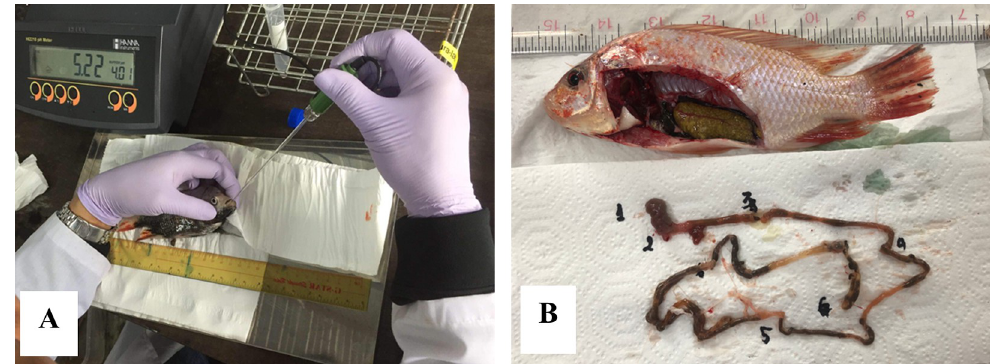
Fig 1. pH measurement of gastrointestinal tract of tilapia: A–Mouth; B– 1. Anterior stomach, 2. Posterior stomach; 3,4,5,6: intestine.